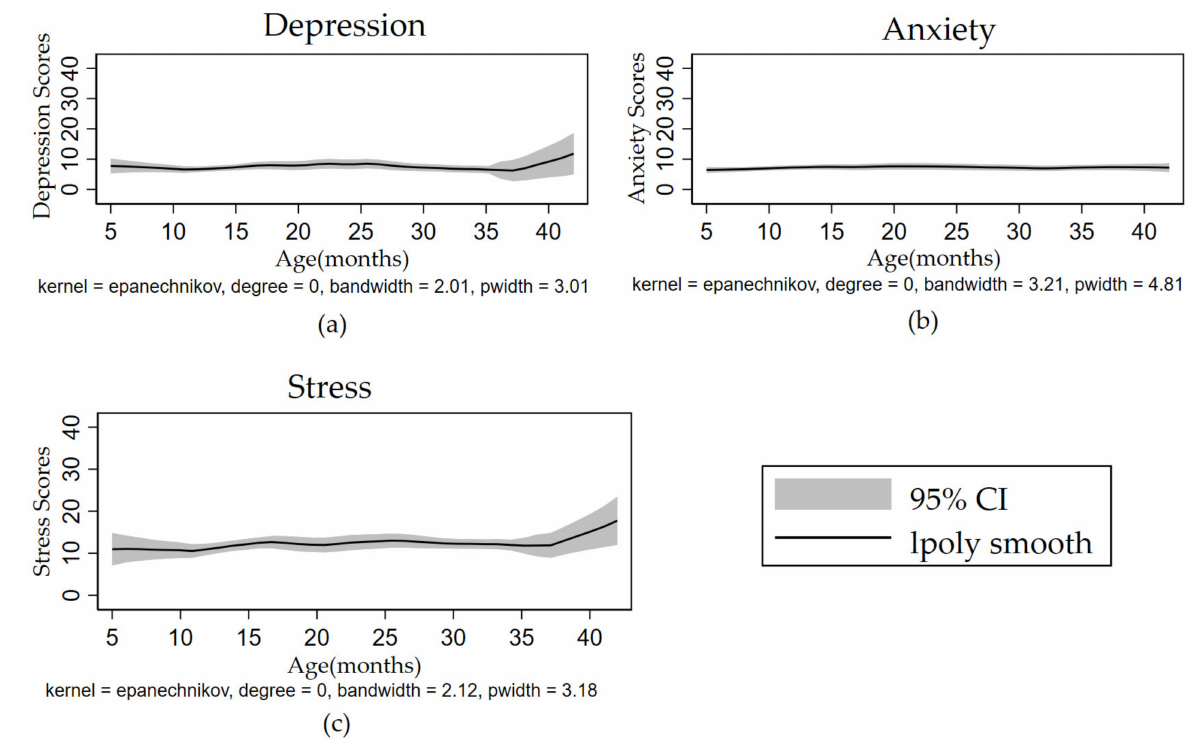
Figure 3. Trends in mental health over time for female caregivers in the control group: ( a ) Depression; ( b ) Anxiety; ( c )